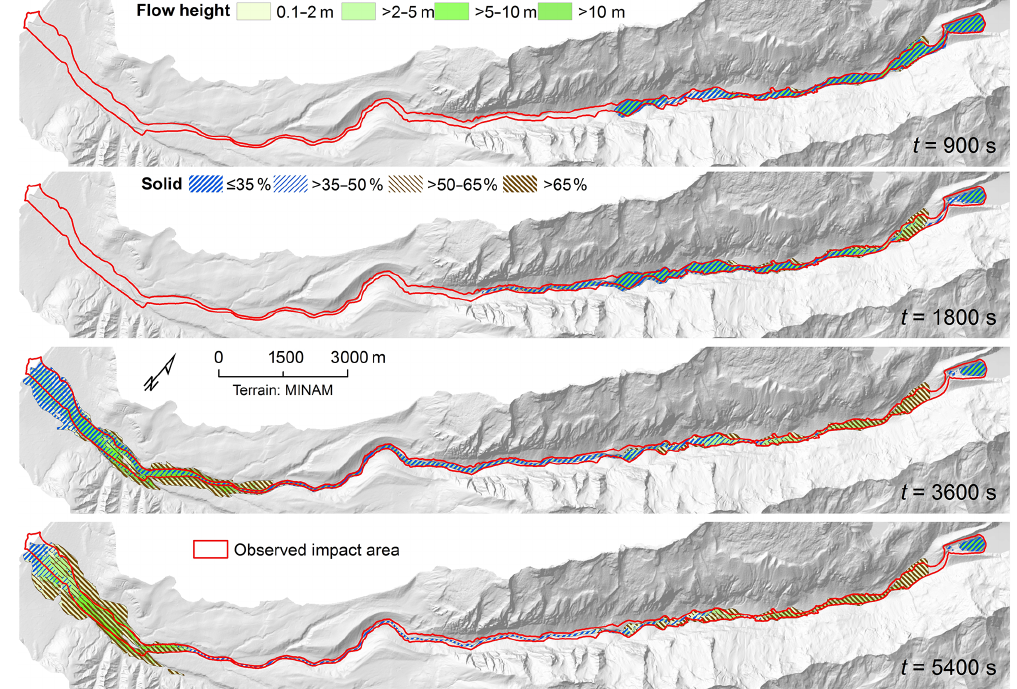
Figure 8. Evolution of the flow in space and time (Scenario